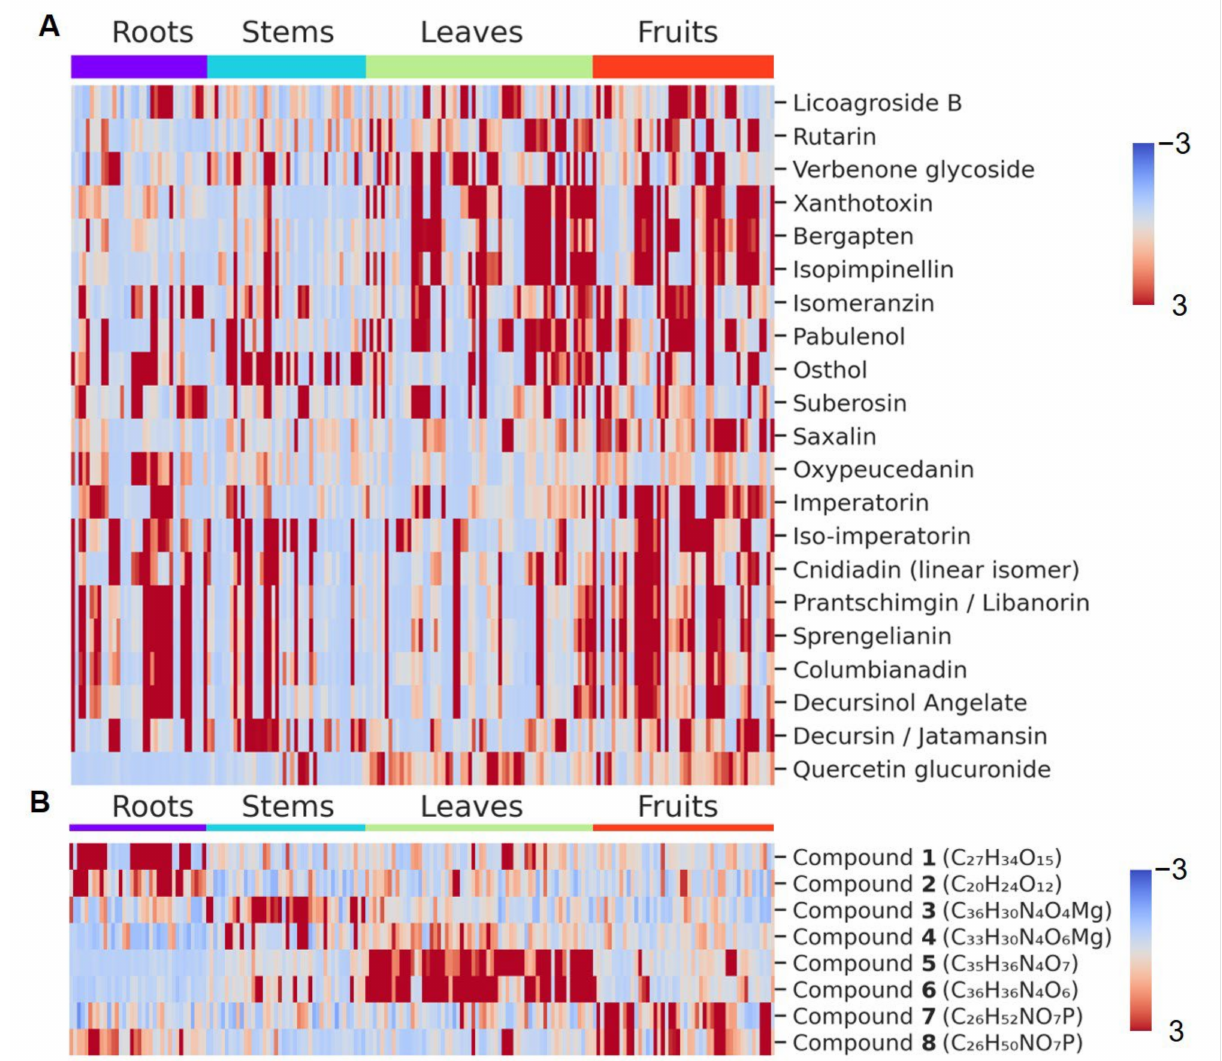
Figure 3. Plant part distribution of coumarins ( A ) and the annotated compounds ( B